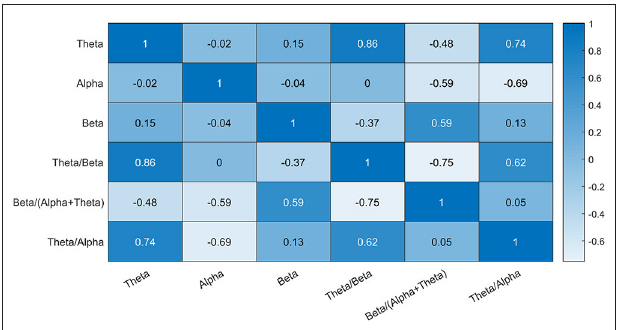
FIGURE 6 | Strength and direction of correlations among the EEG features.